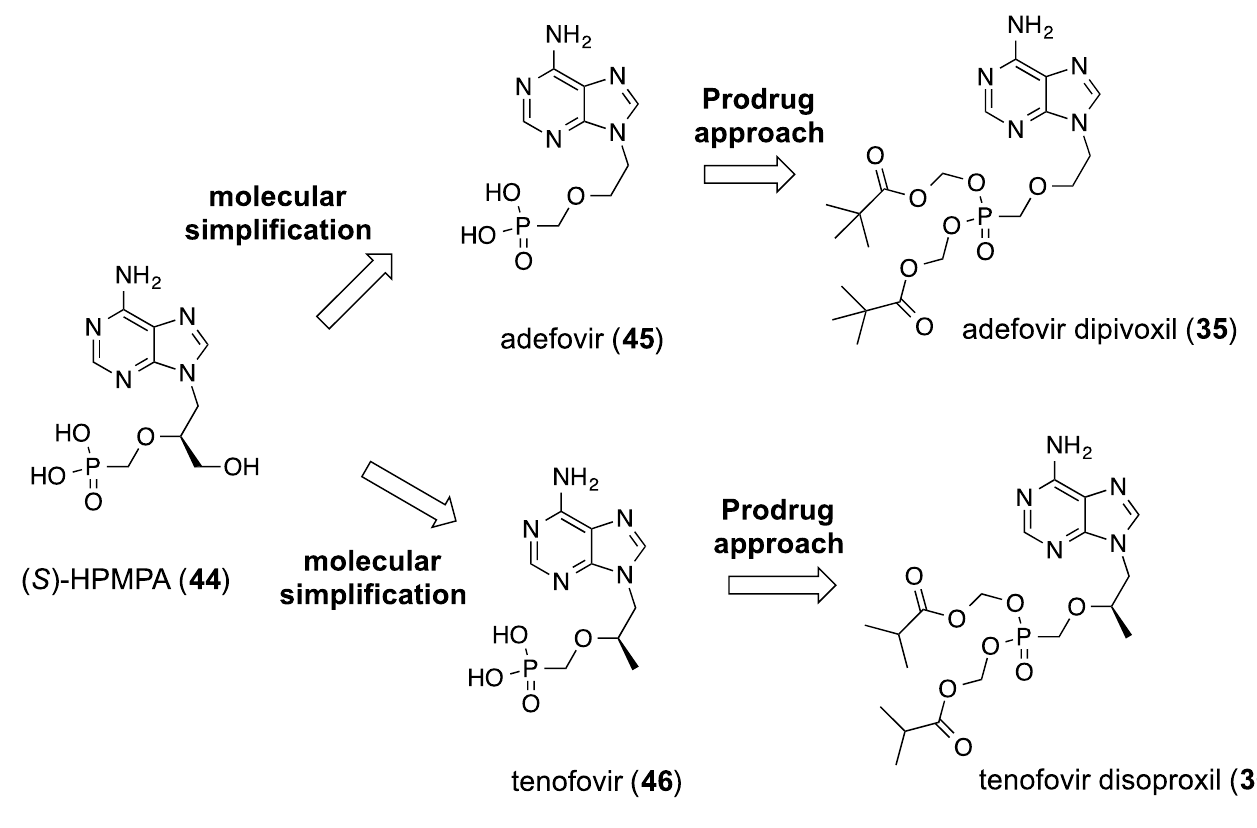
FIGURE 4 - Development of adefovir dipivoxil (35) and tenofovir disoproxil fumarate (36) as a result of academia-industry